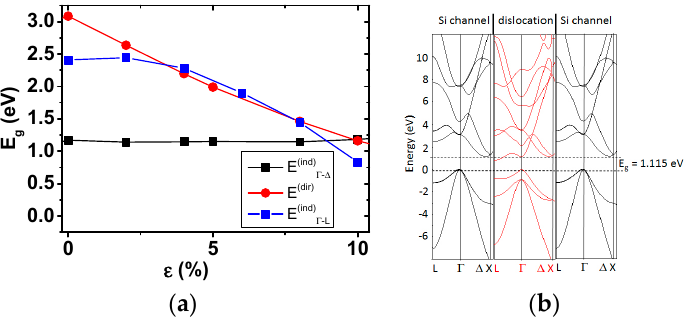
Figure 16. Direct and indirect band gaps ( a ) and Schema of the band diagram of a Si channel with a dislocation in the center ( b ). The shift of the conduction band of the strained dislocation core results in a one-dimensional defect band in the gap of the surrounding channel. For calculation, uniaxial strain ( ε [110] = +0.1, tensile) is assumed. The valence band maximum was set to zero. Dotted lines designate the band gap in the unstrained silicon ( E g = 1.115 eV).